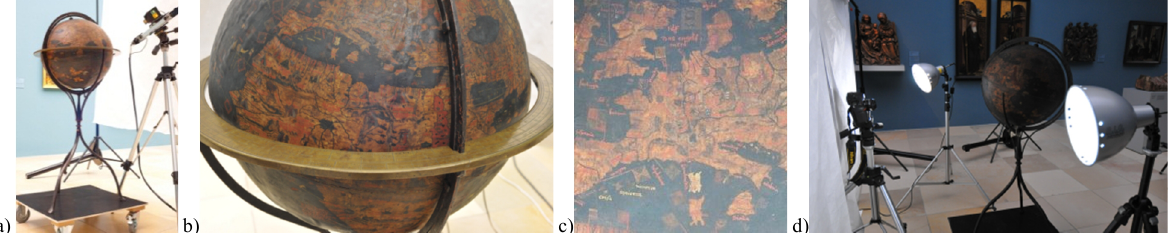
Fig. 1: The Behaim globe, preserved in the German National Museum in Nuremberg, (a) placed on a trolley during the surveying. (b) The equator and supporting ring and (c) a close view to central Europe. (d) The lighting conditions during the image